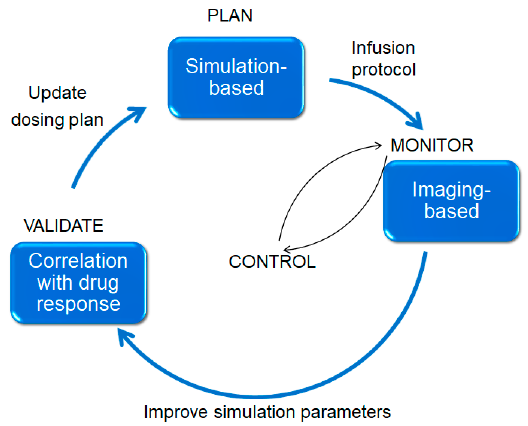
Figure 18. Interventional feedback loop.